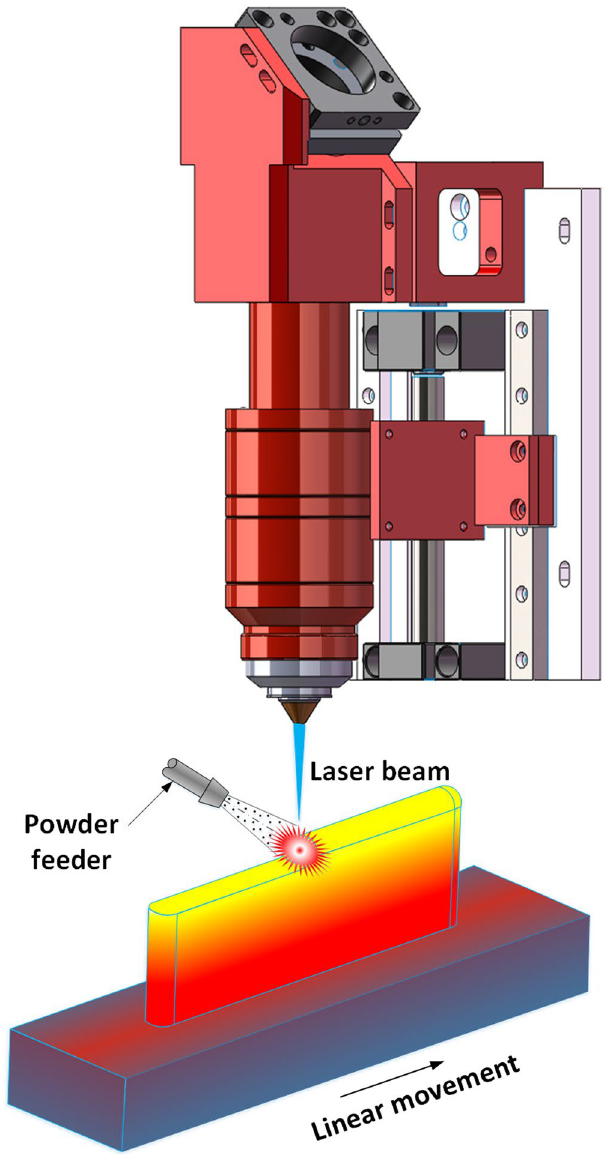
Figure 1. Laser 3D Printing